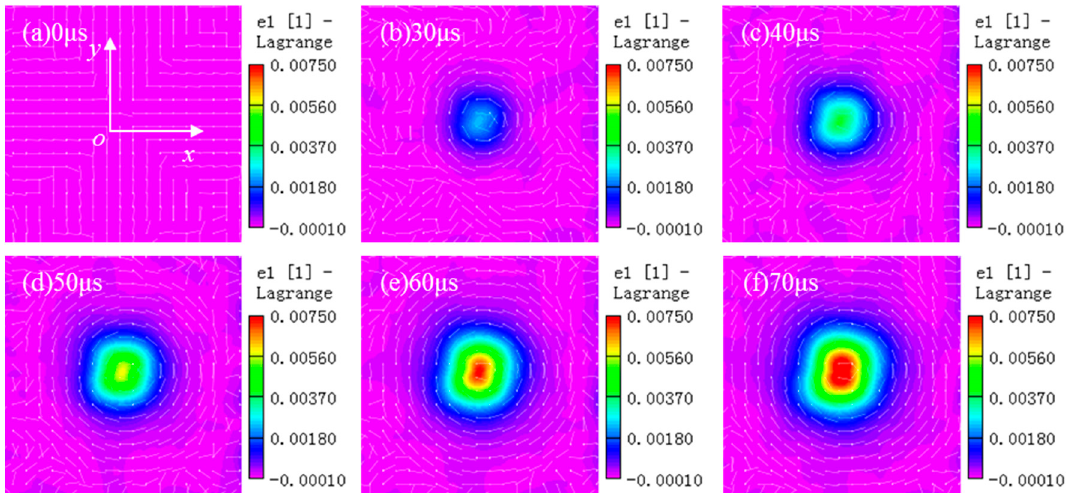
Figure 3. Magnitude and direction of maximum principal strain on the free surface in case of no static load: ( a – f ) images of maximum principal strain after 0 μ s, 30 μ s, 40 μ s, 50 μ s, 60 μ s and 70 μ s of static load: ( a – f ) images of maximum principal strain after 0 µ s, 30 µ s, 40 µ s, 50 µ s, 60 µ s and 70 µ s explosion. of